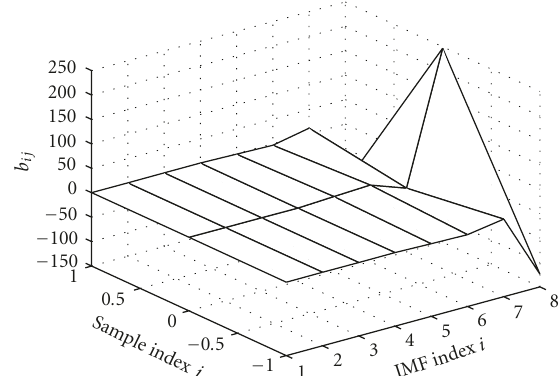
Figure 2: Optimal coe ffi cients b ij ’s for the BOSR.